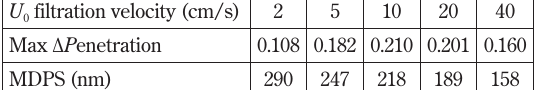
Fig. 8 Penetration values for spherical and agglom- erated nanoparticles from model calculations at the filtration velocities of 2, 5, 10, 20 and 40 cm/s. Table 2 The maximum penetration difference between spheres and agglomerates and the corre- sponding most differentiating particle size (MDPS) at different filtration